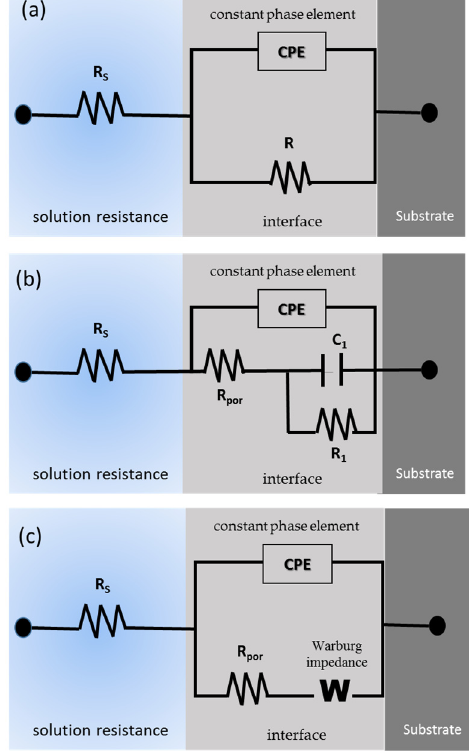
Figure 8. Equivalent circuit for ( a ) uncoated Ti-6Al-2Sn-4Zr-2Mo in NaCl and Ti-6Al-4V. ( b ) Ti-6Al- 2Sn-4Zr-2Mo in H 2 SO 4 and ( c ) for all the anodized samples.